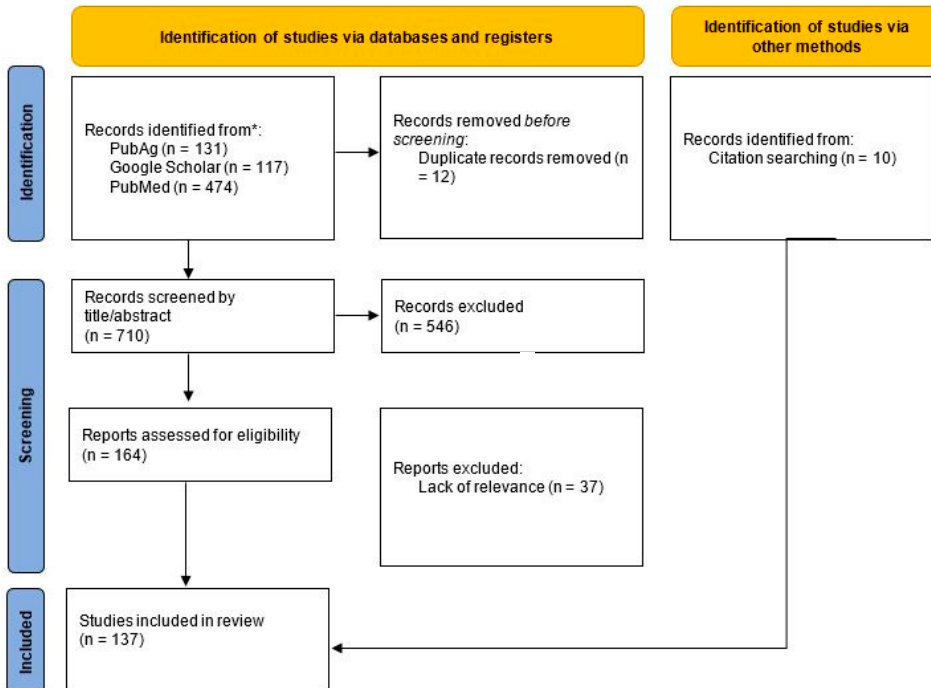
Figure 1. PRISMA Framework used for review. * Records retrieved from databases using Boolean search term: (agriculture or farming) and (automation or technology) and (“climate change” or “environmental change”).